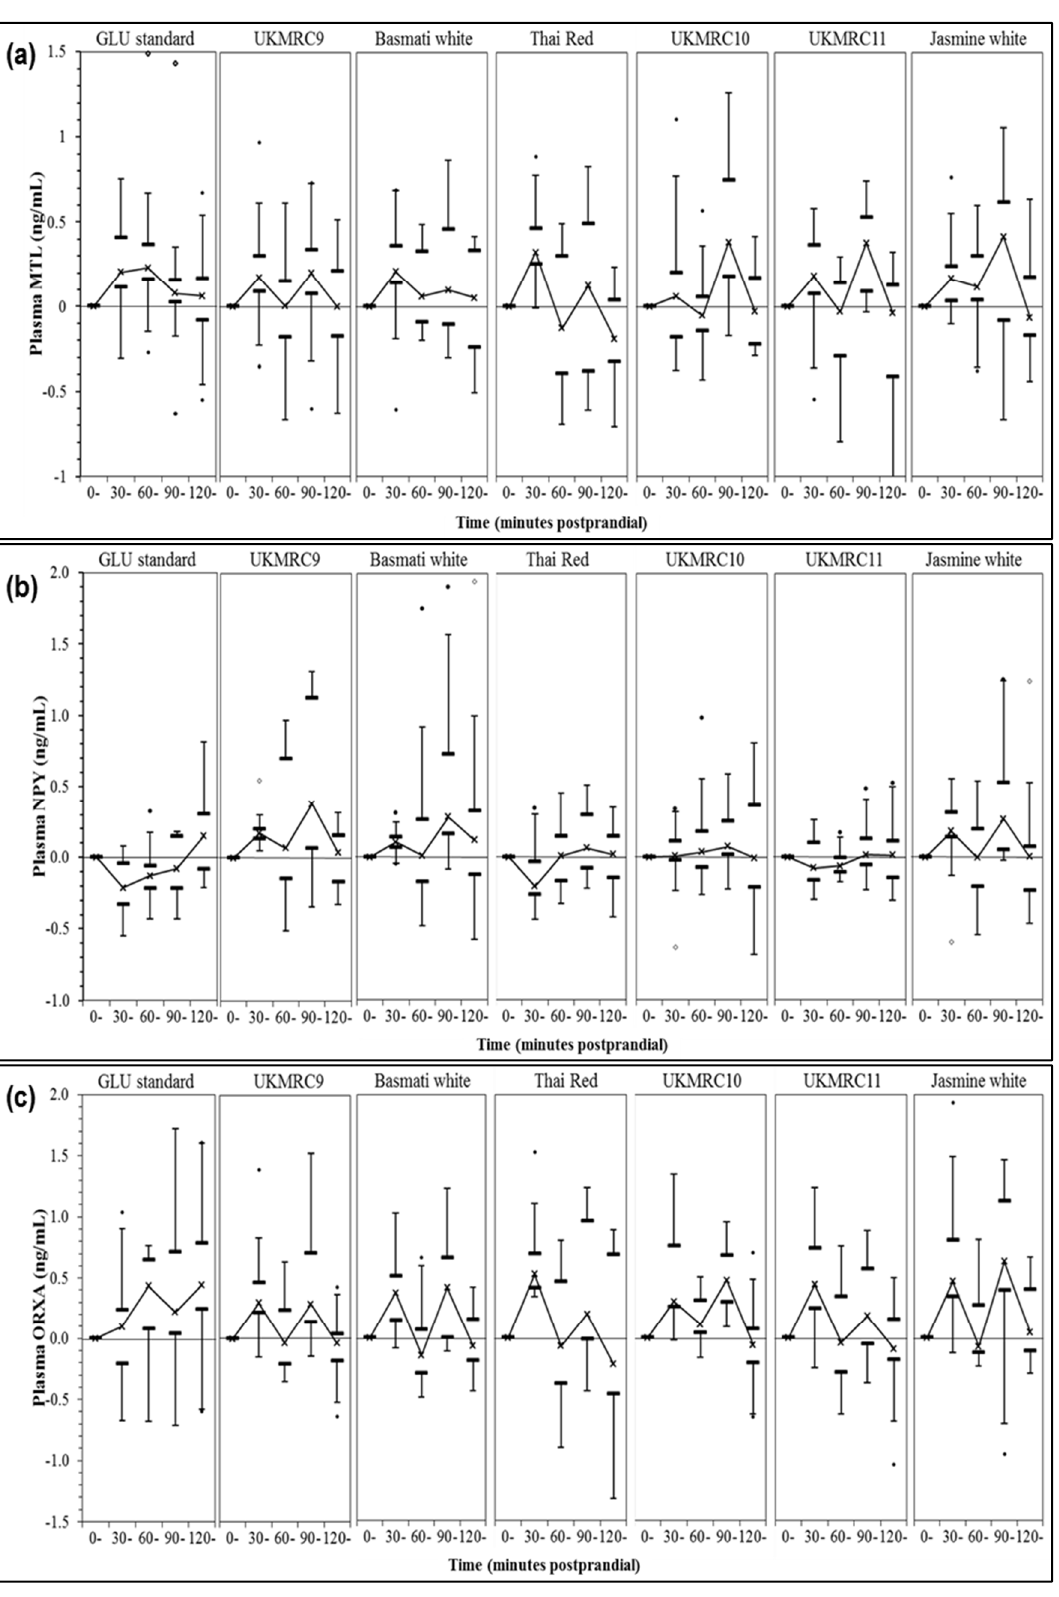
Figure 2. Baseline ‐ adjusted trends in postprandial plasma ( a ) motilin (MTL); ( b ) neuropeptide ‐ Y (NPY) and ( c ) orexin ‐ A (ORXA) responses for six test rice and glucose standard. Note: Horizontal bars = smallest and largest values; Lower band = 25th percentile; Upper band = 75th percentile; (×) = median; (•) = outlier and ( ) = extreme values defined as 1.5 × (Q3 − Q1) below 25th or above 75th percentiles.